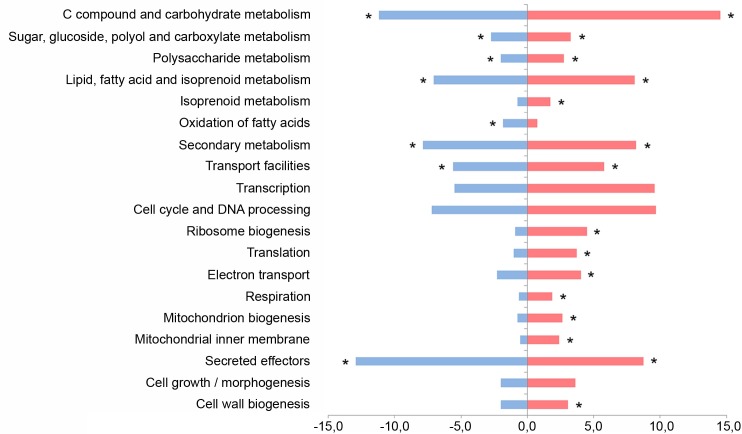
Cellular processes regulated by Ros1.Functional enrichment analysis of the differentially regulated genes identified by RNA-seq in FB1 x FB2 compared to FB1Δros1 x FB2Δros1 strains 8 days after infection of maize seedlings. Analysis was performed using the FunRich program and FunCat annotations available on the MIPS Ustilago maydis database (http://www.helmholtz-muenchen.de). The category “secreted effectors” was added and refers to all genes encoding secreted proteins without annotated functional domain. The chart shows the proportion of genes belonging to selected functional categories in the up-regulated (red) and down-regulated (blue) gene sets. Overrepresented categories in each up and downregulated gene sets compared to the global gene distribution are indicated with asterisks (p ≤ 0.05).